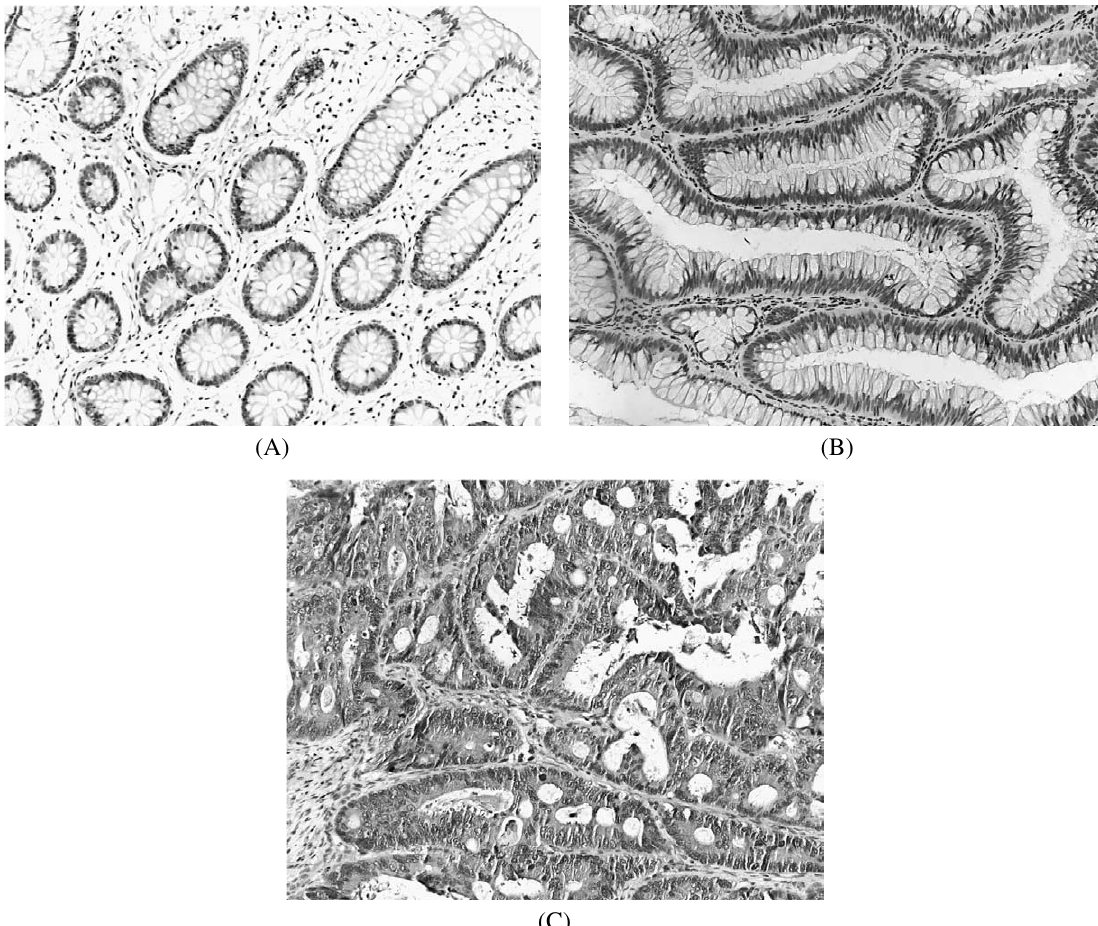
Fig. 6. Representative examples of expression of cFLIP in normal colon tissue, colorectal adenomas and carcinomas. (A) Normal colonic ep- ithelium showing negative staining. (B) Colon adenoma showing negative staining. (C) Colon carcinoma representing strong cytoplasmic stain- ing ( +